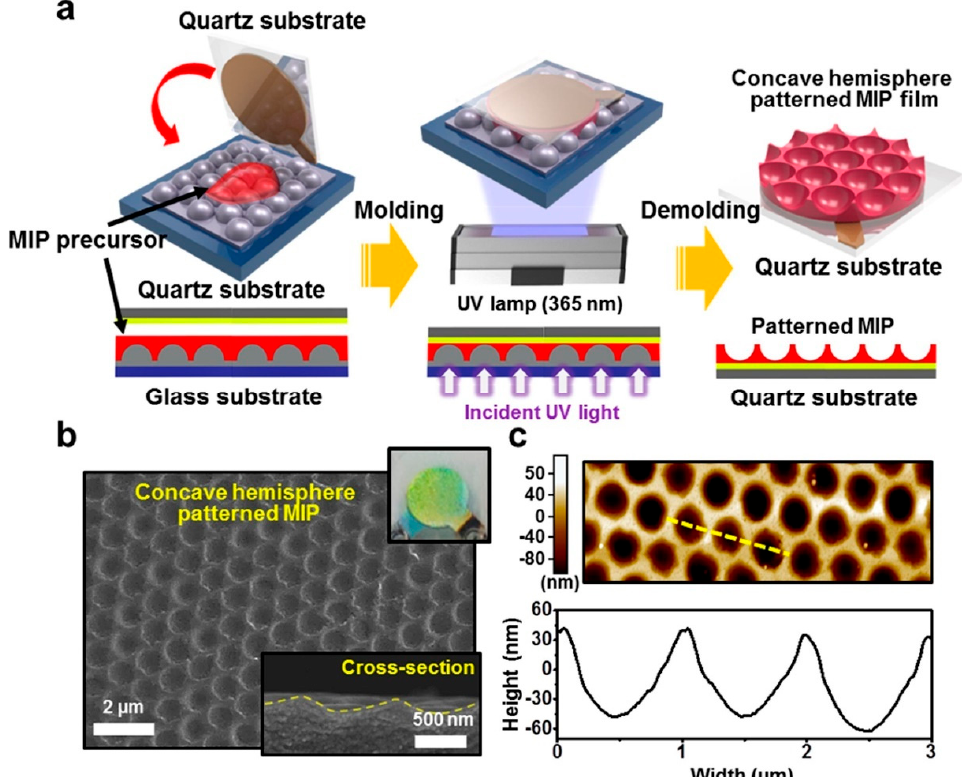
Figure 2. ( a ) Flowchart of the step and flash imprint lithography procedure employed to form pore-arrayed MIP films on quartz crystals. ( b ) Representative scanning electron microscopy image of the surface of the concave hemispherical patterned MIP film (upper inset: a digital image of quartz crystal microbalance － based MIP sensor; lower inset: a cross － sectional view of the ultrathin MIP film. ( c ) Atomic force microscopy image of the concave porous MIP film (top) and corresponding height profile [85]. (Copyright (2021) ELSEVIER).